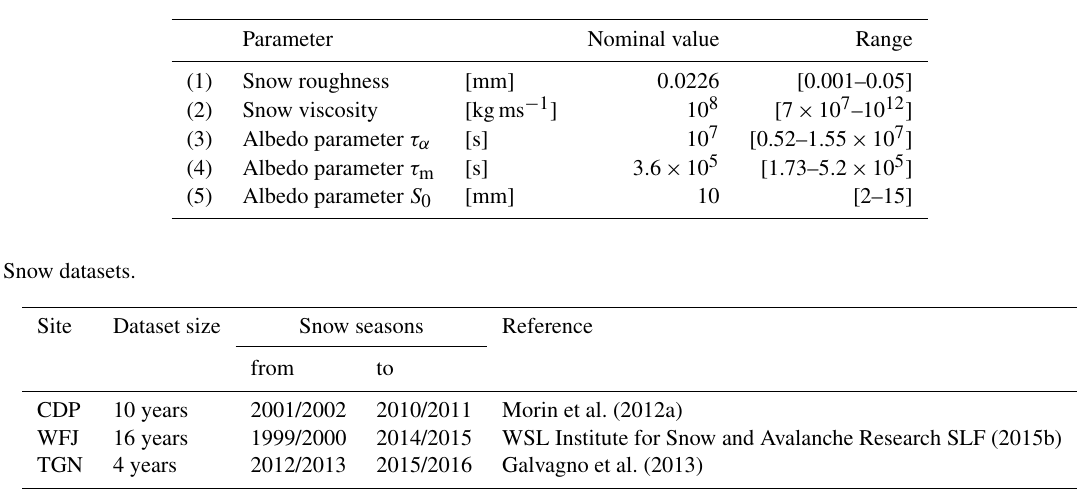
Table 2. Sensitivity analysis and selected model parameters.